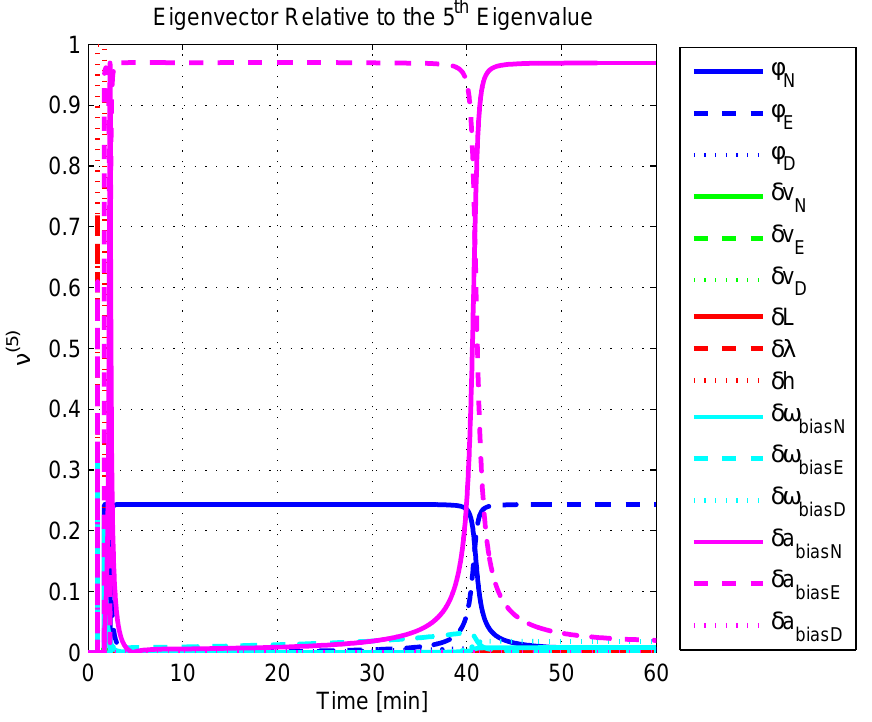
Figure 24. Eigenvector relative to the fifth eigenvalue in the repeated experimental